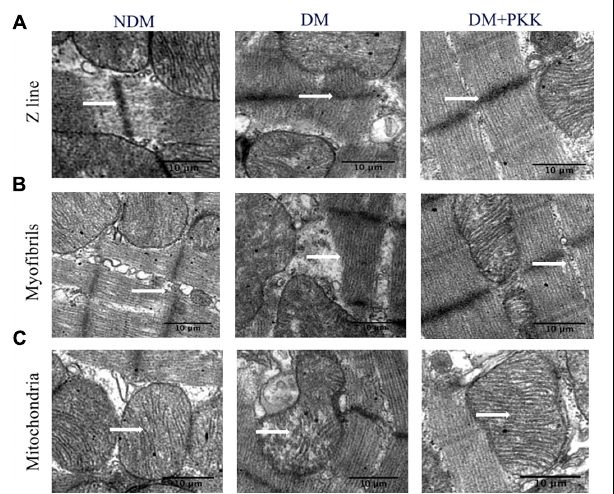
FIGURE 1 | Pancreatic kallikrein administration improved the ultrastructure of diabetic cardiomyopathy in STZ-induced diabetic rats. The ultra-microstructures for arrangement of (A,B) myocardial fibers and (C) mitochondria. In the DM group, myocardial fibers, as well as mitochondria, were misarranged. Irregular arrangement of myofibrils was observed and Z lines were obscured. The mitochondrial structures showed signs of swelling and breakage of cristae. White arrows represent Z lines, myofibrils or mitochondria. However, pancreatic kallikrein (PKK) treatment reversed these pathological changes compared with the DM group.